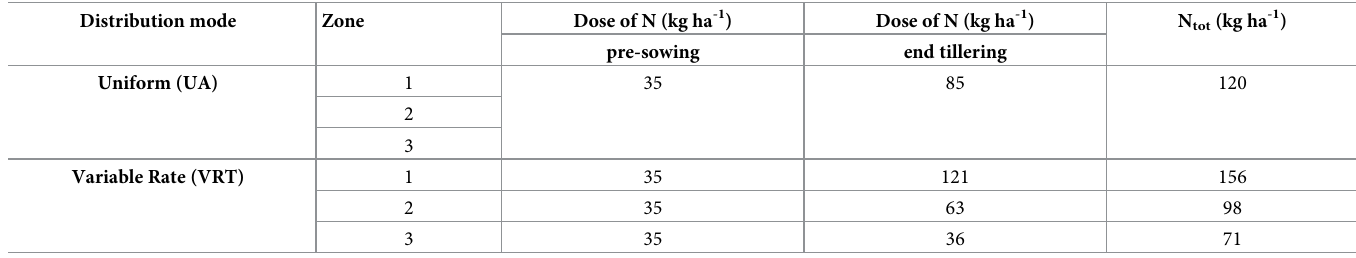
Table 1. Units of N supplied in the different experimental